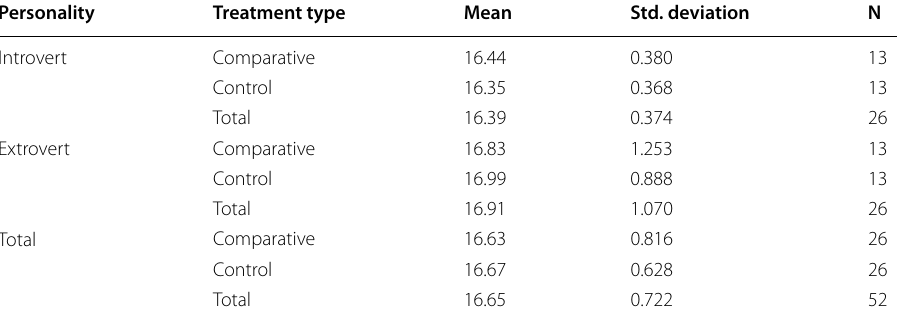
Table 2 The results of descriptive statistics for scores of pretests Personality